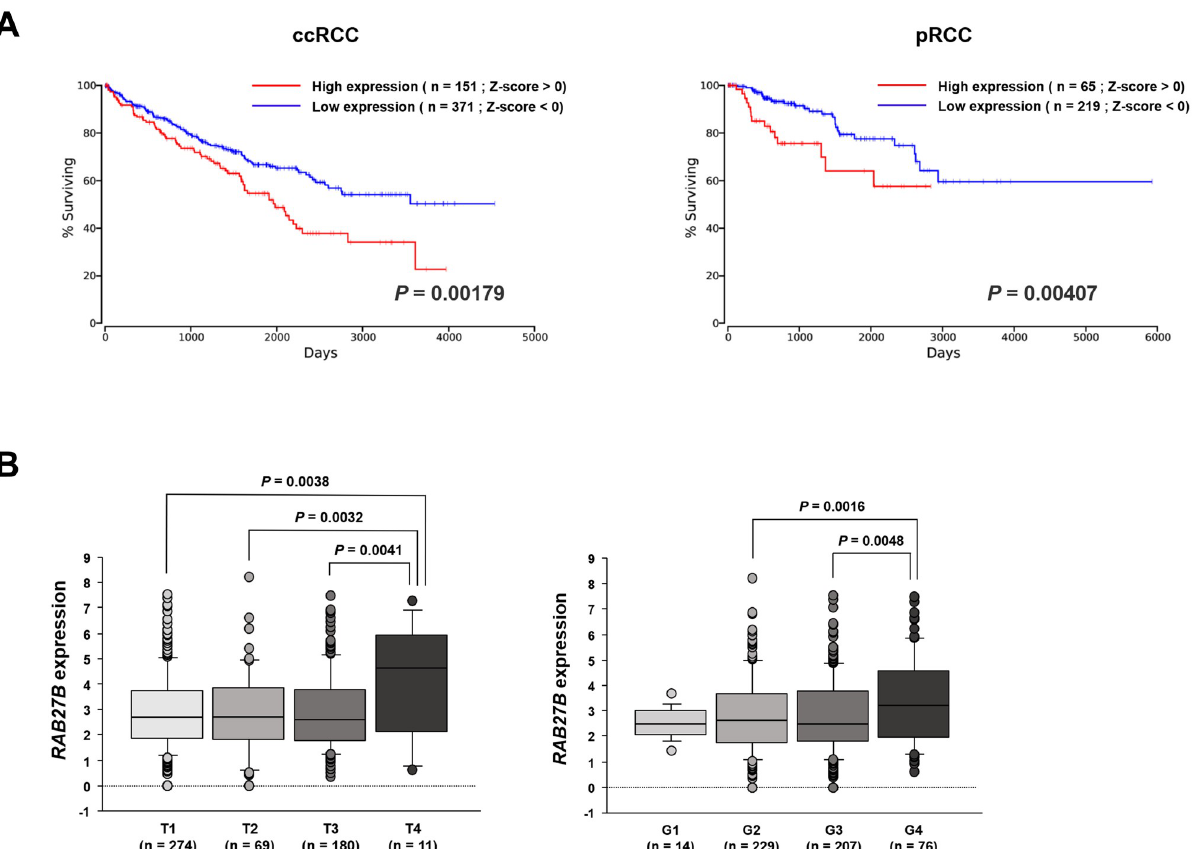
Fig 1. AT proteome profile analysis. B (A) A Venn diagram comparing BAT proteome large-scale studies. (B) The quantitative protein abundance ranges in BAT samples and the proteins that included a secreted signal peptide according to the iBAQ algorithm.